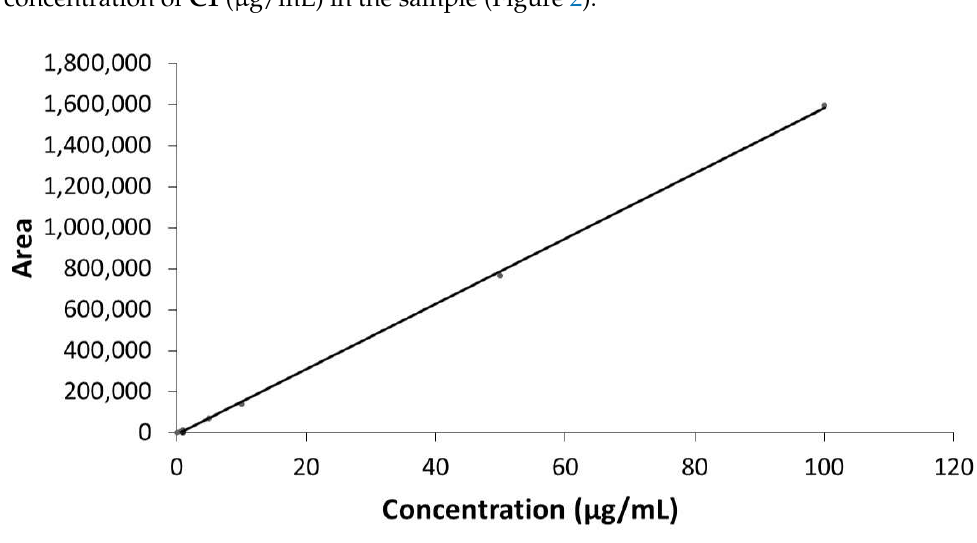
Figure 2. The calibration curve of C1 . The calibration curves were constructed in triplicate, plotting the known concentrations of the calibration standards (0.1, 0.5, 1, 5, 10, 50, and 100 µ g/mL) versus the response area of the